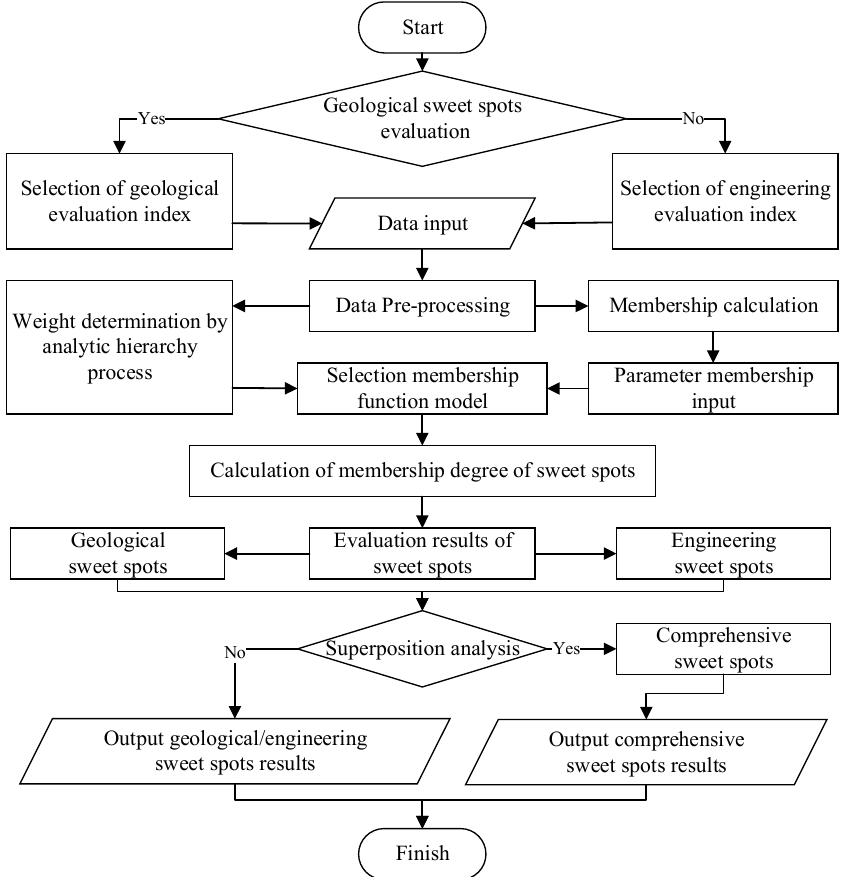
Figure 2. Technical process of geological and engineering sweet spots evaluation and comprehensive sweet spots superposition evaluation based on fuzzy comprehensive evaluation.